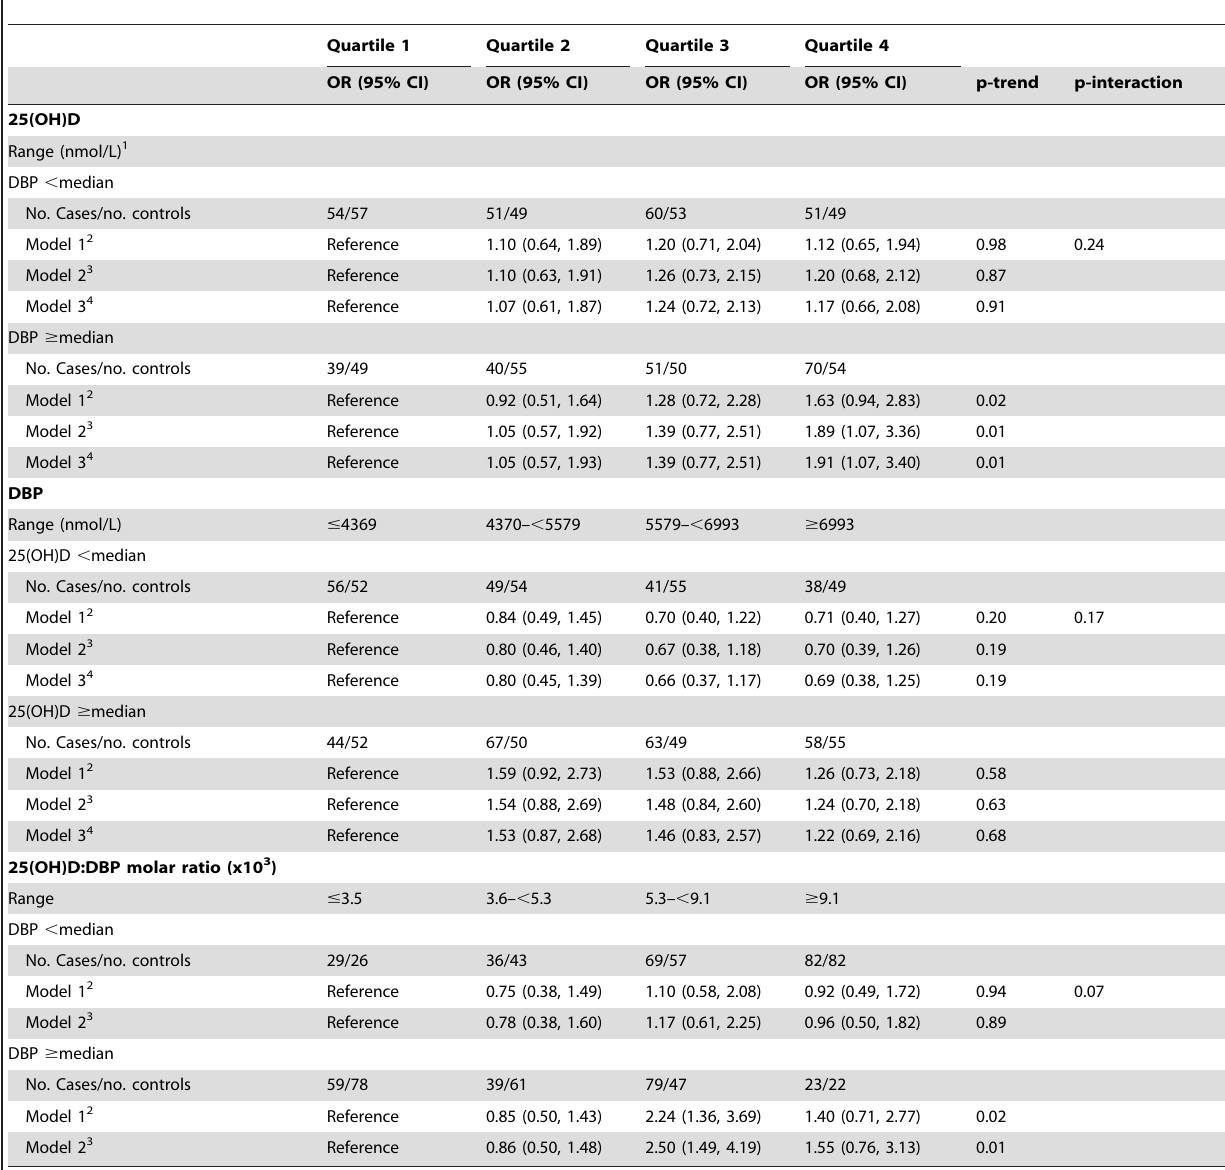
Table 3. Odds ratios and 95% confidence intervals for the association between serum 25(OH)D, DBP, and the 25(OH)D:DBP molar ratio and colorectal cancer risk in stratified models, ATBC